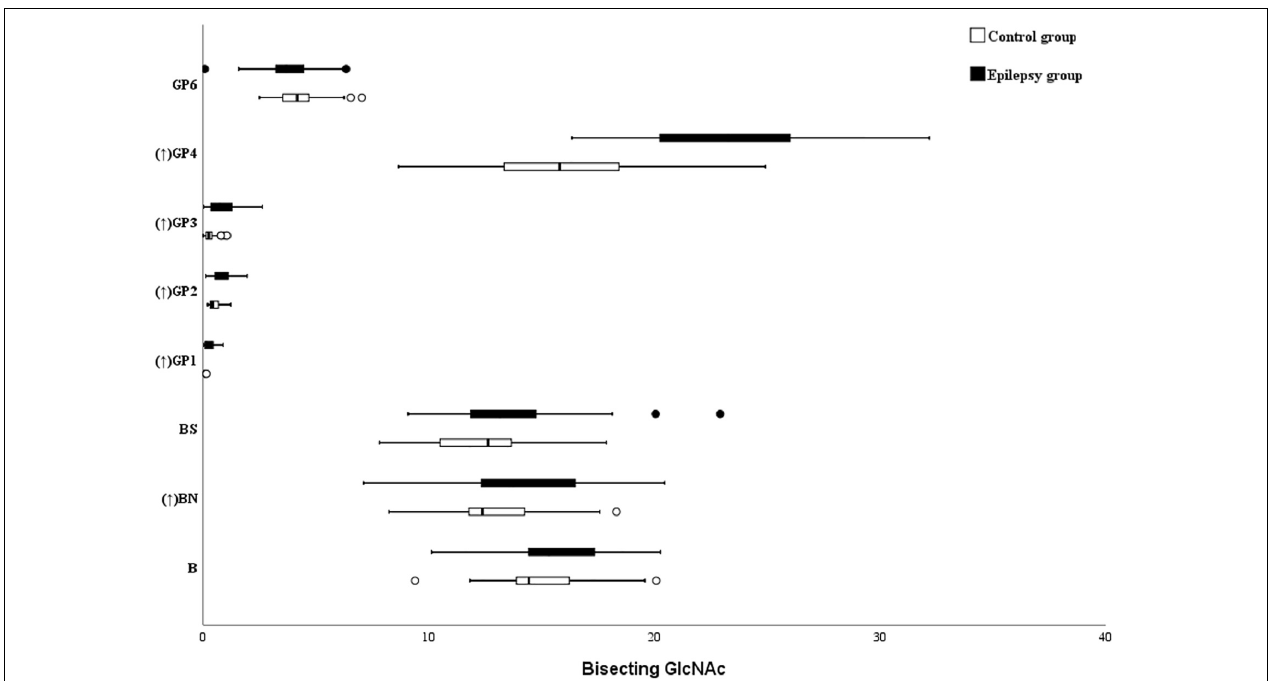
FIGURE 4 | Bisecting GlcNAc on Ig G in Epilepsy patients and the healthy controls. GP, glycan peak; S, Sialic acid; B, bisecting N-acetylglucosamine (GlcNAc); G, galactose; ↑ , the glycan in Epilepsy group in significantly higher than that in the controls; and ↓ the glycan in Epilepsy group in significantly lower than that in the